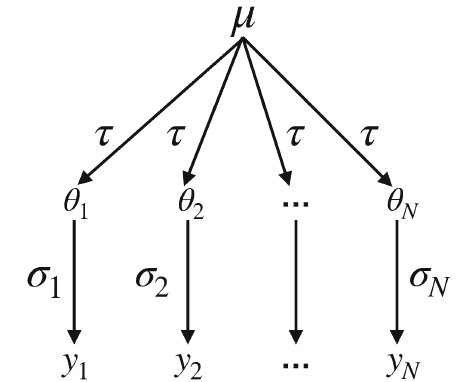
Fig. 2 Hierarchicalmodel.Eachexperimentalparameter θ i arisesfrom a random draw from a parent distribution with hyper-parameters μ and τ , and each experimental central value y i is then considered to be the result of a random draw from a Gaussian distribution with central value θ σ i and error